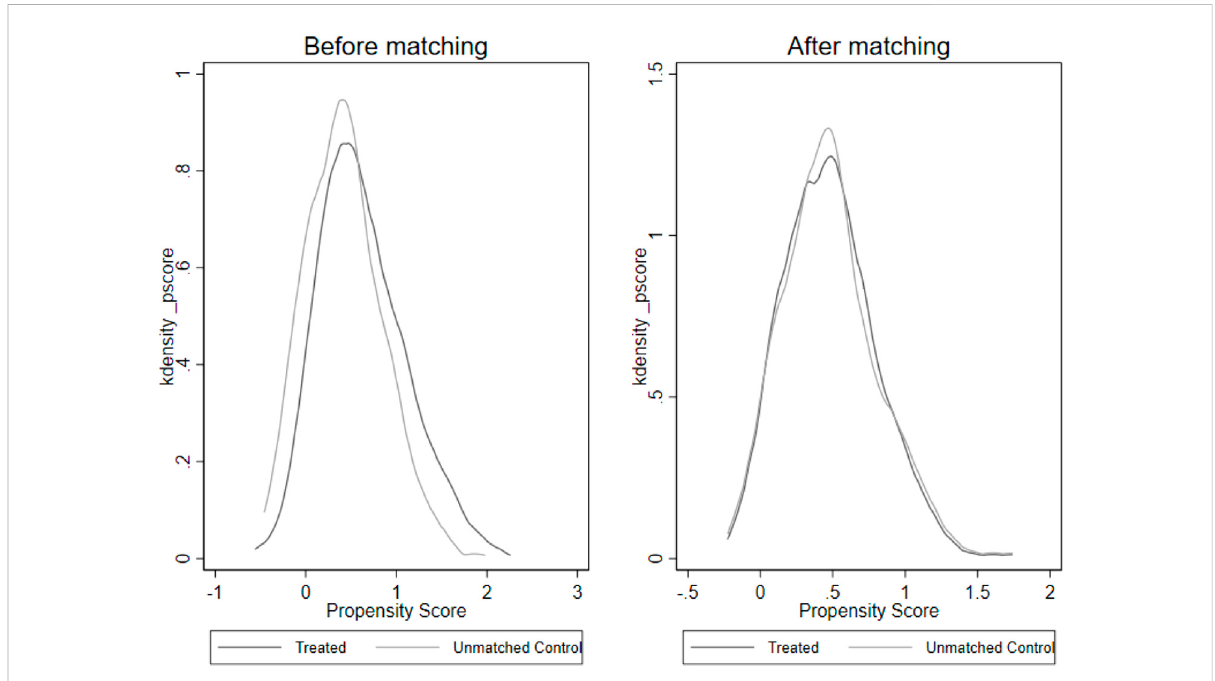
FIGURE A1 Propensity score of the treated, matched and unmatched